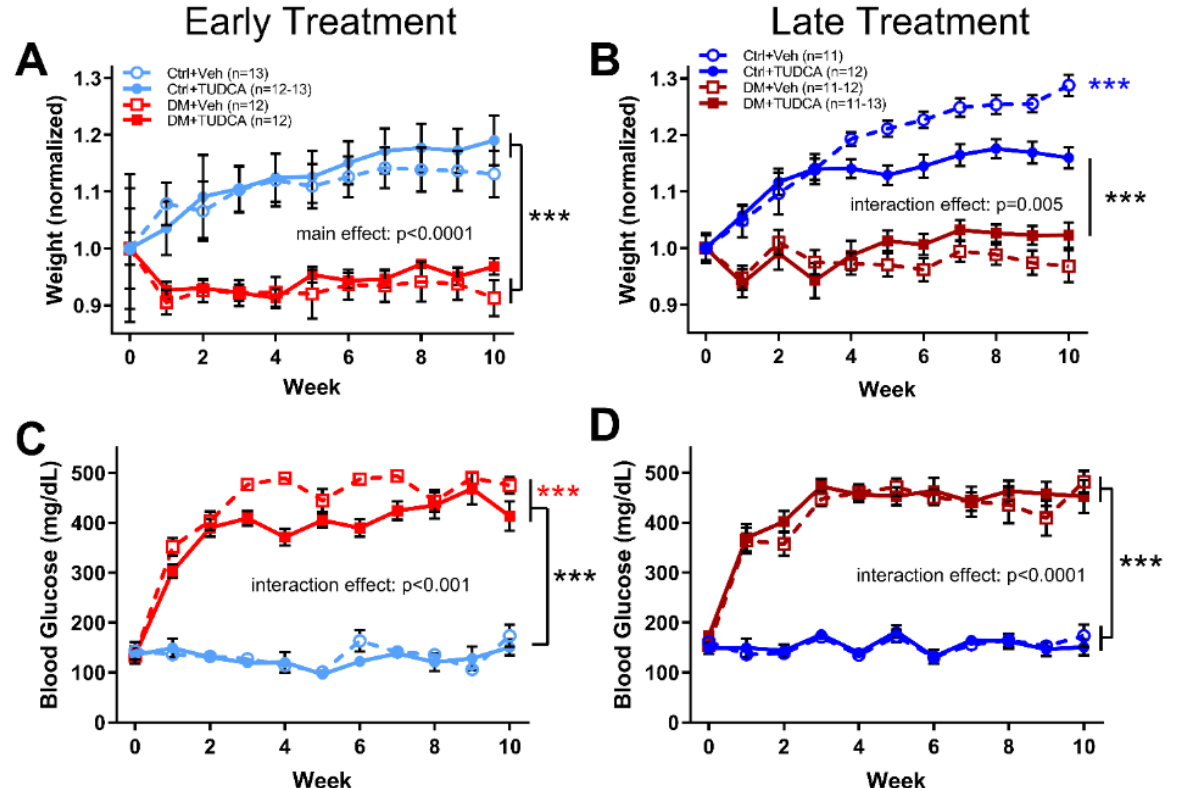
Figure 1. Effects of DM and TUDCA treatment on body weight and blood glucose. ( A ) Early treatment body weight, normalized to mean baseline (0 week timepoint) weight by group. As animals aged, the Ctrl groups weighed significantly more than the DM groups (two-way ANOVA, F 3,506 = 1.831, main effect p < 0.0001). ( B ) Late treatment body weight, normalized to baseline by group at 0-week timepoint. Again, the DM groups weighed significantly less than the Ctrl groups. However, the Ctrl + TUDCA group also weighed less than the Ctrl+Veh group (*** p < 0.0001) (two-way ANOVA, F 30,484 = 4.330, interaction effect p < 0.0001). ( C ) In the early treatment experiment, blood glucose levels were significantly higher in both DM groups compared to Ctrl groups (two-way ANOVA, F 30,506 = 15.19, interaction effect p < 0.0001). In addition, the DM+TUDCA group had significantly lower blood glucose than the DM+Veh group (*** p < 0.0001). ( D ) In the late treatment experiments, blood glucose in the DM groups was significantly higher than the Ctrl groups (two-way ANOVA, F 30,484 = 7.604, interaction effect p < 0.0001). Holm–Sidak post hoc comparisons indicated by